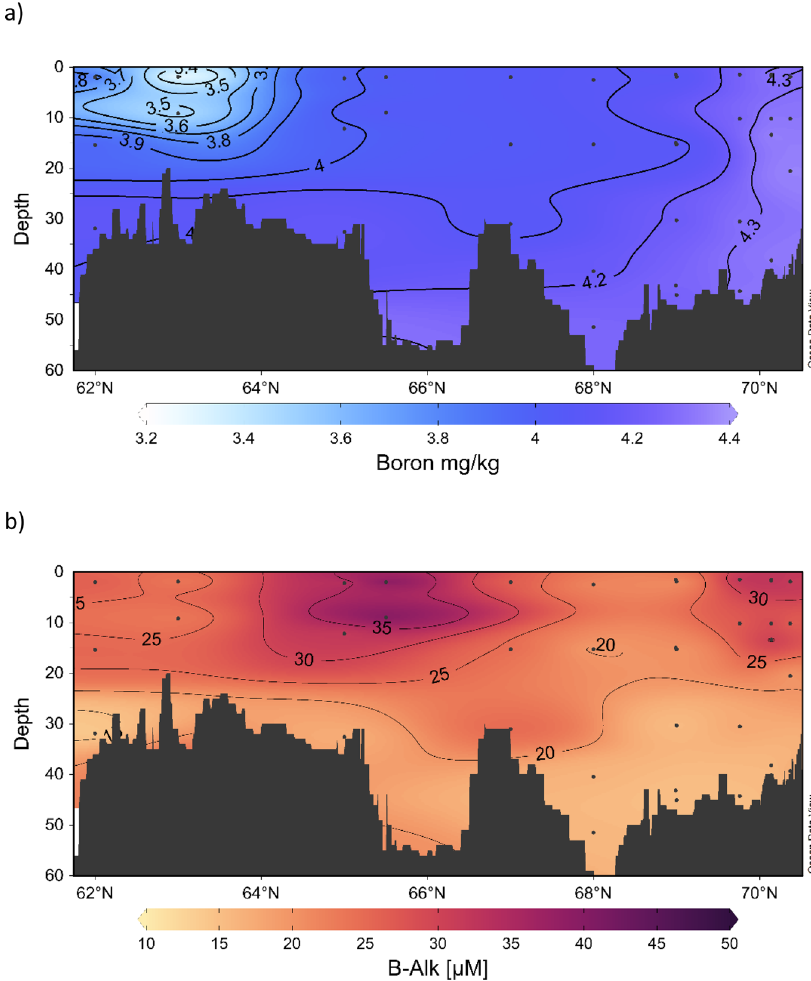
Fig. 2 Depth pro fi les. a Total boron concentrations in mg kg − 1 and b alkalinity due to borate (B-Alk) in µ mol kg − 1 .